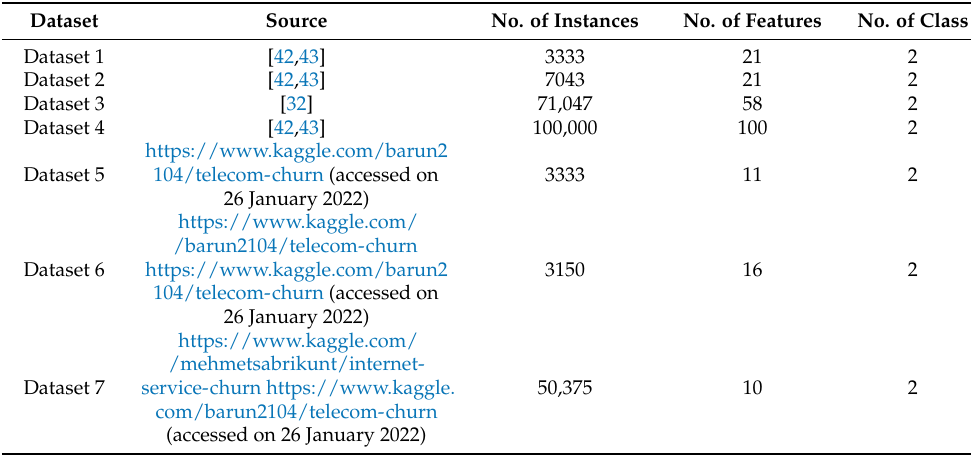
Table 1. The characteristics of the open-source customer churn datasets.